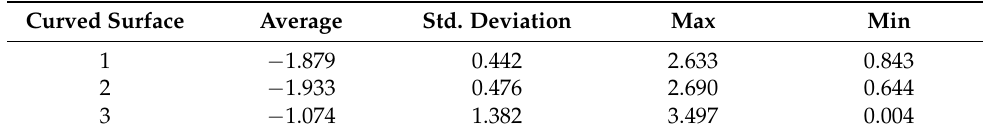
Table 2. Errors in the positions of the curved surfaces (unit: mm).